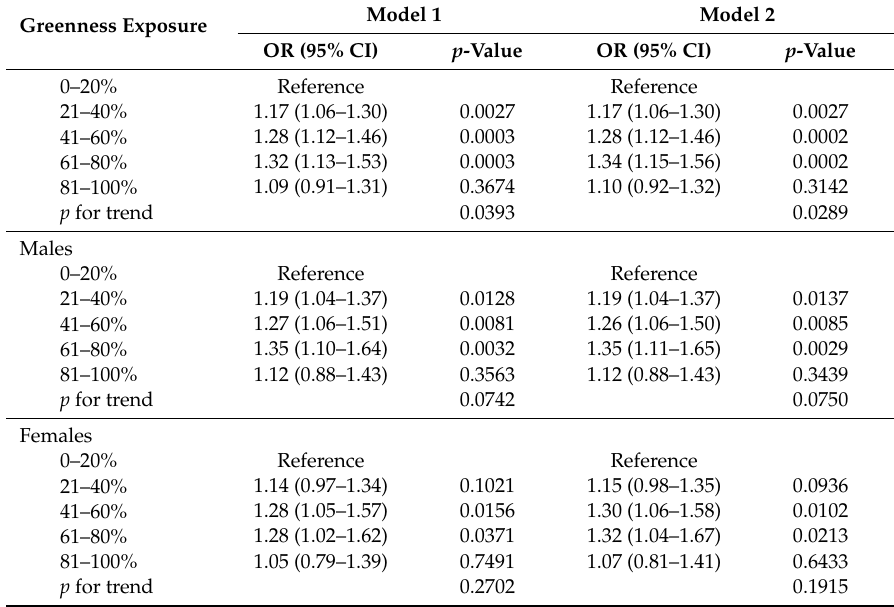
Table 2. Odds ratios (OR) and 95% confidence intervals (CIs) for asthma occurrence according to the level of greenness exposure before the age of 18.